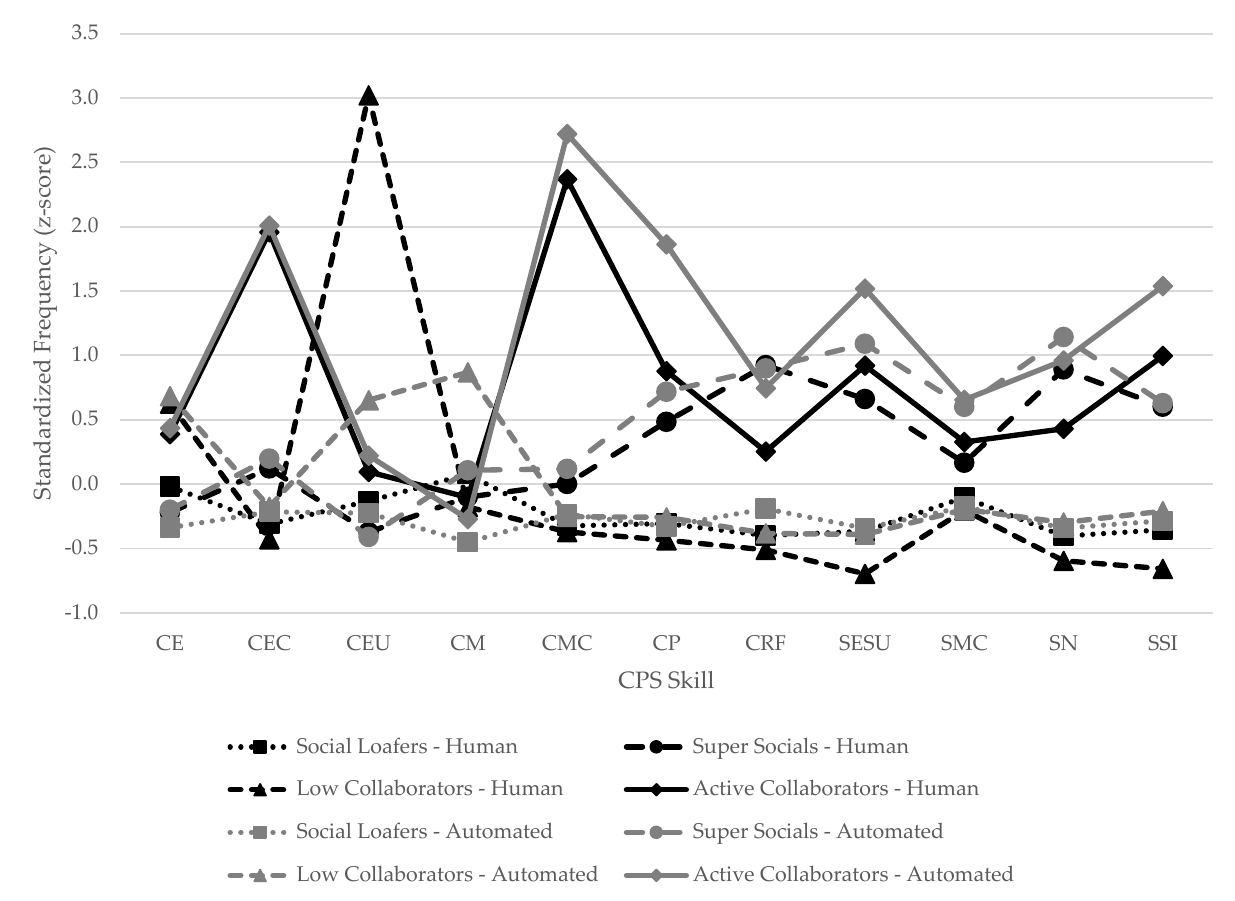
Figure 2. Line plot of standardized frequencies of CPS skills by cluster and annotation method. Table 6. Comparison of cluster analysis results based on counts of participants in each cluster across annotation methods.